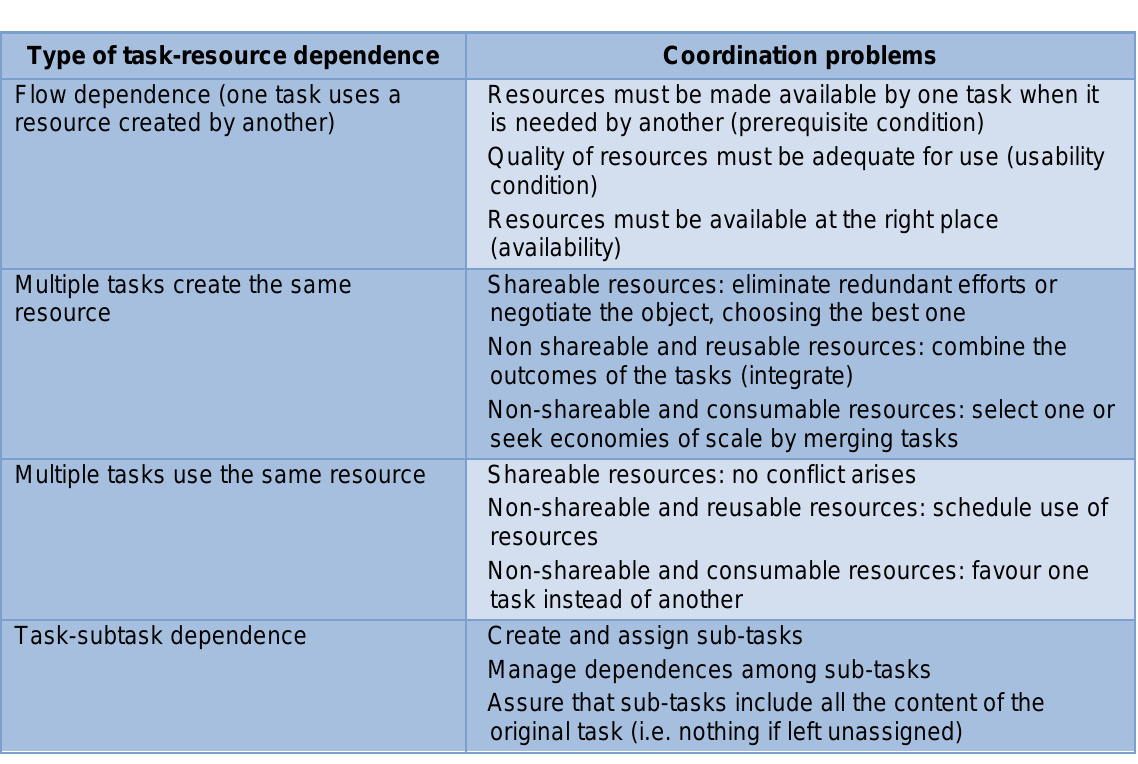
Table 3 Types of dependences and corresponding coordination problems (based on Crowston, 1991 and Crowston and Osborn,